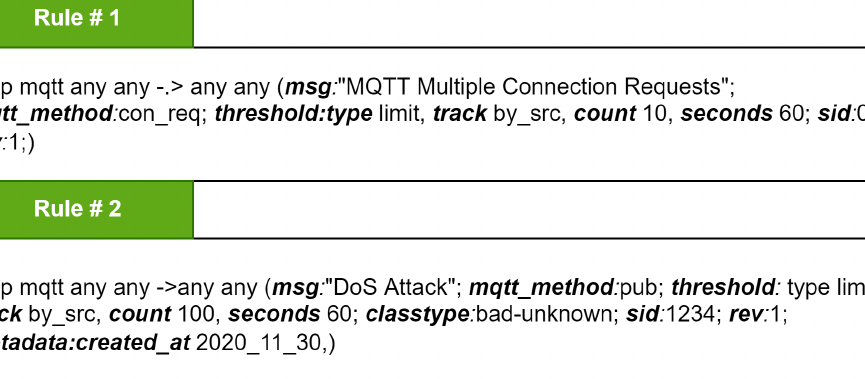
Figure 7. Sample rules defined in Suricata to detect and prevent MQTT flooding